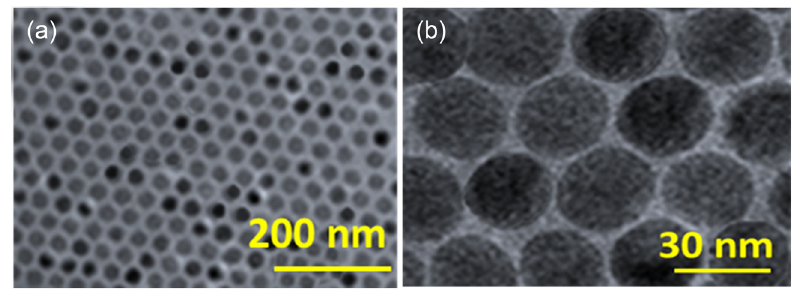
Figure 3: TEM images of AuNPs with high ( a ) and low magni fi cation ( b )